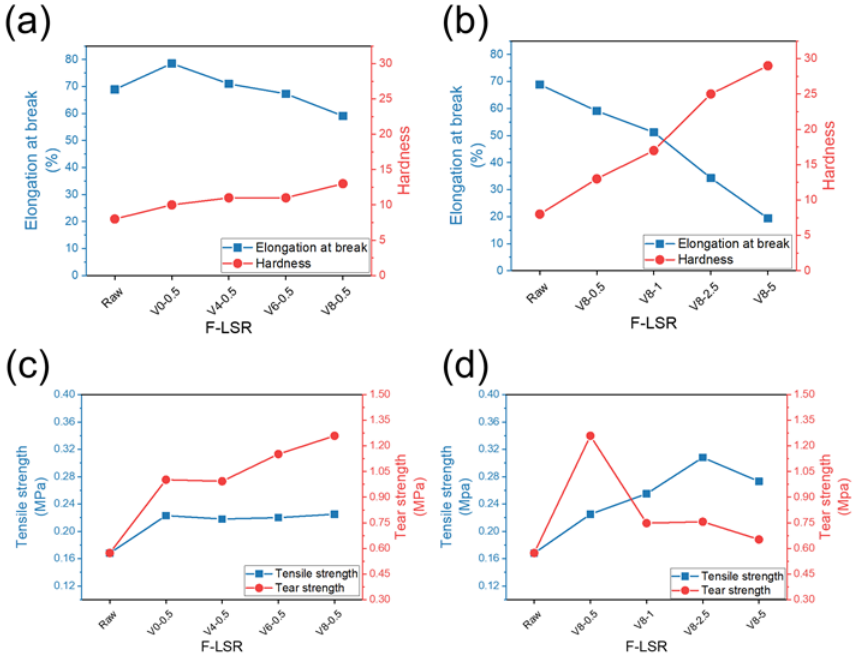
Figure 4. Mechanical properties of the F-LSR-POSSs: ( a , b ) elongation and hardness of the F-LSR-POSSs and ( c , d ) tensile and tear strengths of the F-LSR-POSSs. Table 2. Mechanical properties of the F-LSR-POSSs.